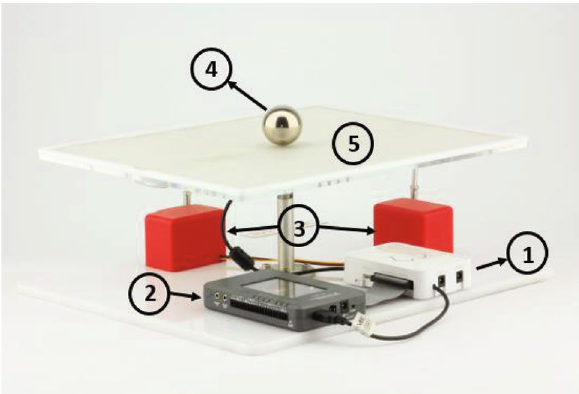
Fig. 1 Parts of the BBT system: 1. Power distribution box 2. NI myRIO 3. RC servos 4. Steel ball 5. 2D resistive touch sensor and controller